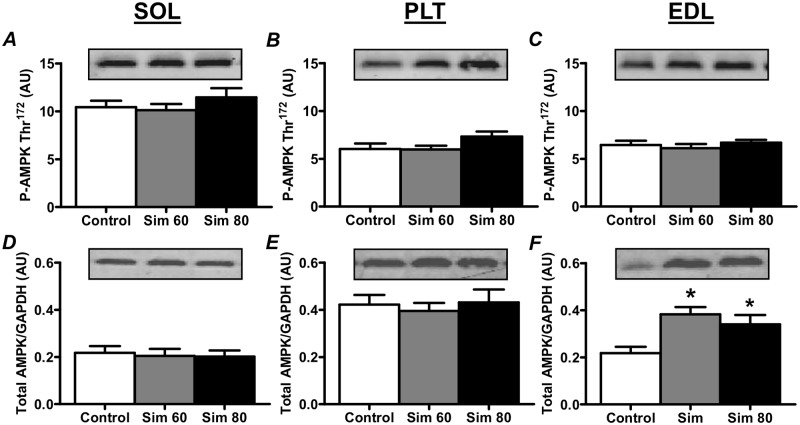
The effect of simvastatin treatment on the AMPK Thr172 phosphorylation and total AMPK protein expression.Rats were treated with vehicle (Control) or simvastatin at 60 (Sim 60) and 80 mg.kg-1.day-1 (Sim 80) for 14 days. Muscles were collected and subjected to Western blot analysis with the indicated antibodies as described in the Methods. Values for total AMPK were normalised to GAPDH. All values are expressed as arbitrary units (AU). *—significantly different from Control. Mean ± SEM. n = 8/group. One way ANOVA with Newman-Keul’s post-hoc test. P < 0.05.